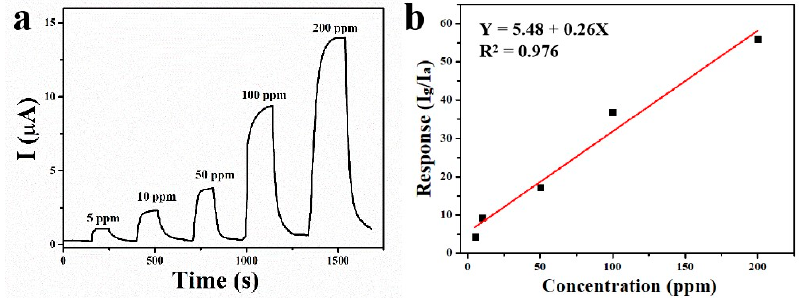
Figure 9. ( a ) Real − time responses of the GO/ZnO nanosheet composites to n − propanol at different concentrations at 300 °C, ( b ) the corresponding plots of the response vs. concentration.